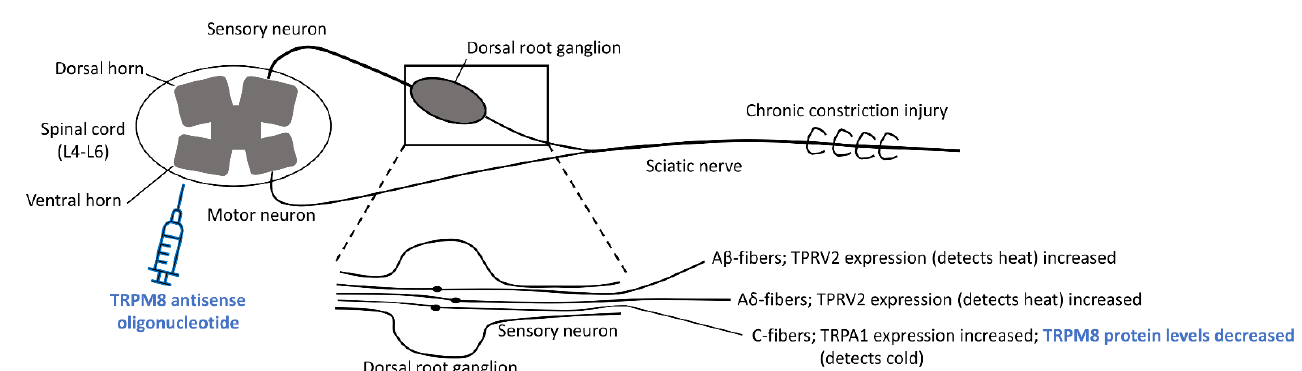
Figure 3. The role of the transient receptor potential channel (TRP) family in cold allodynia. ( A ) Sensory A β - and A δ -fibres express TRPV2 activated by heat stimulus > 52 ◦ C. C-fibres express TRPA1 activated by cold (5–18 ◦ C) and TRPM8 activated by cold (<20 ◦ C). ( B ) During sciatic CCI, cold allodynia was associated with expression of TRPV2, TRPA1, and TRPM8 in the ipsilateral dorsal root ganglia at L4–L6. ( C ) Intrathecal injection of TRPM8 antisense oligonucleotide attenuated cold allodynia and decreased TRPM8 protein levels in the ipsilateral dorsal root ganglia of L4–L6. TRPV2: Transient receptor potential cation channel, subfamily V, member 2; TRPA1: Transient receptor potential cation channel, subfamily A, member 1; TRPM8: Transient receptor potential cation channel, subfamily M, member 8; CCI: Chronic Constriction Injury; L: Lumbar